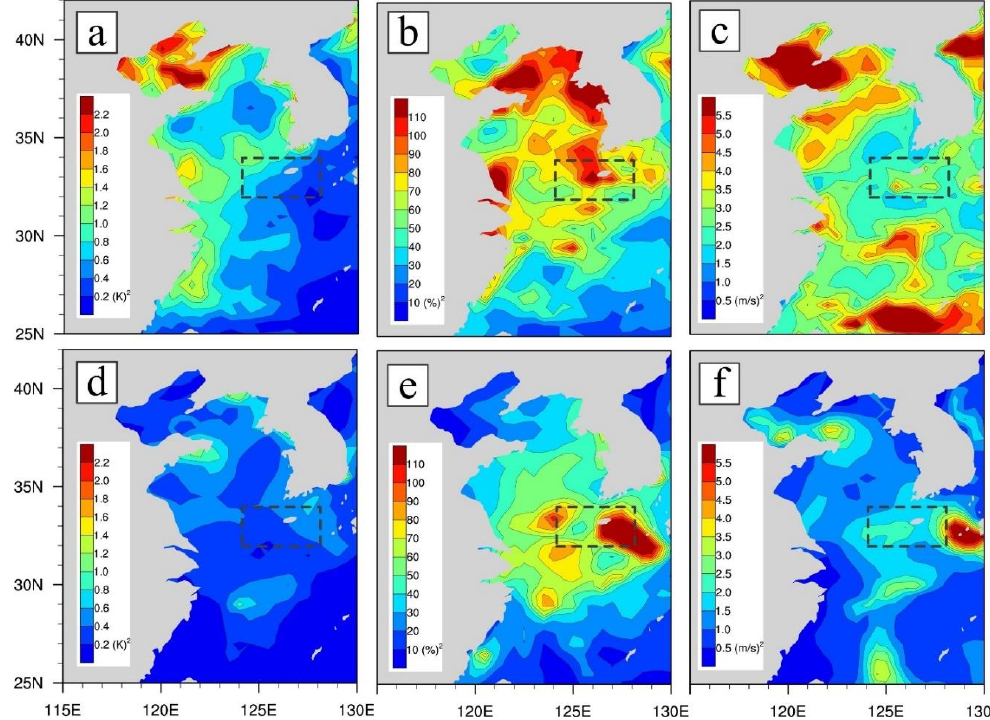
Figure 13. Comparison between the variance distributions at 1000 hPa for temperature ( a , d ), relative humidity ( b , e ) and wind speed ( c , f ) for 3DVAR (upper; Exp-A1) and EnKF (lower; Exp-A3) of the case C-09. The dashed frame indicates the significant zone.